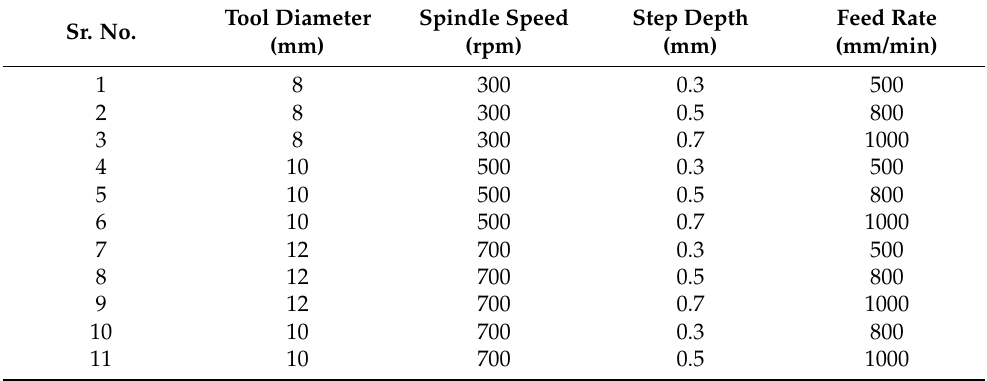
Table 2. Parameters and their levels . Table 3. Experimental